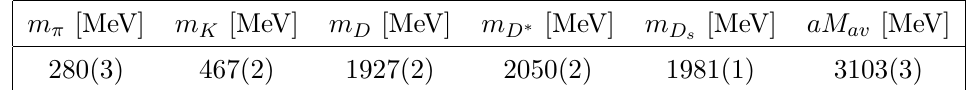
Table 1 . Hadron masses in physical units for the gauge configurations used in this project, where M av = ( m η + 3 m ) / 4 . The hadrons containing charm quarks are from κ c = 0 . 12315 . J/ψ c denoted H105 and U101, have an inverse gauge coupling β = 6 /g 2 = 3 . 4 , corresponding to a lattice spacing a = 0 . 08636(98)(40) fm and volumes N